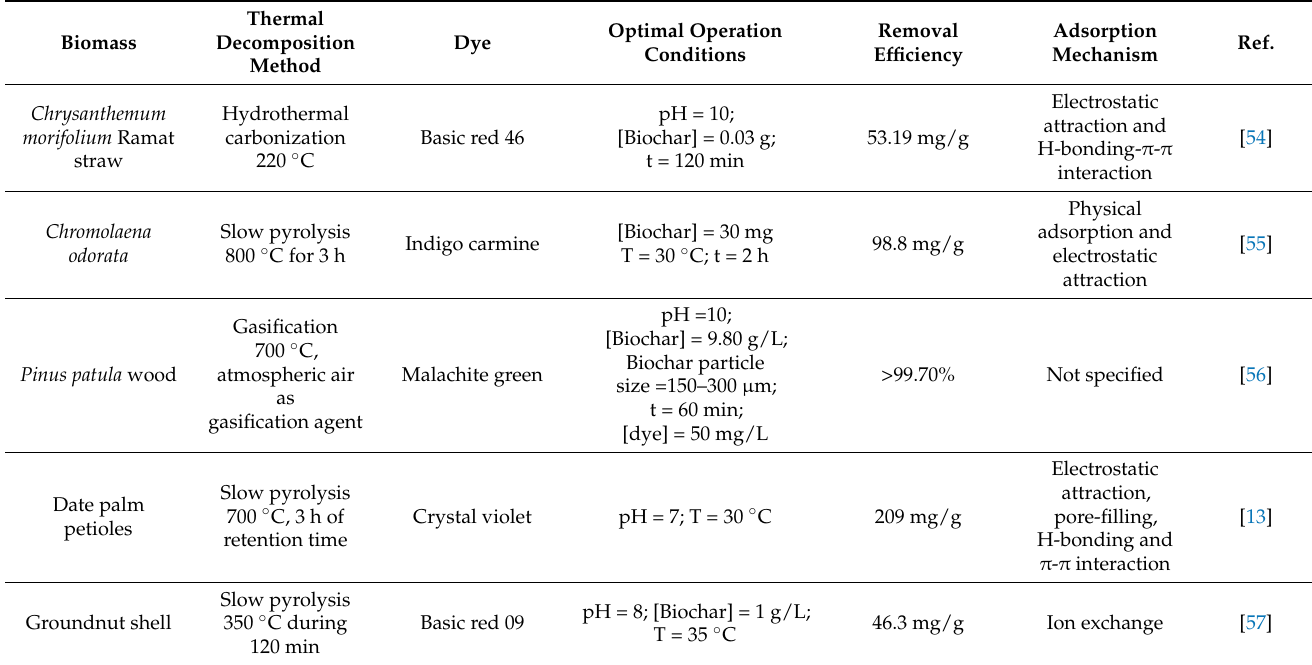
Table 1. Dye removal by adsorption using